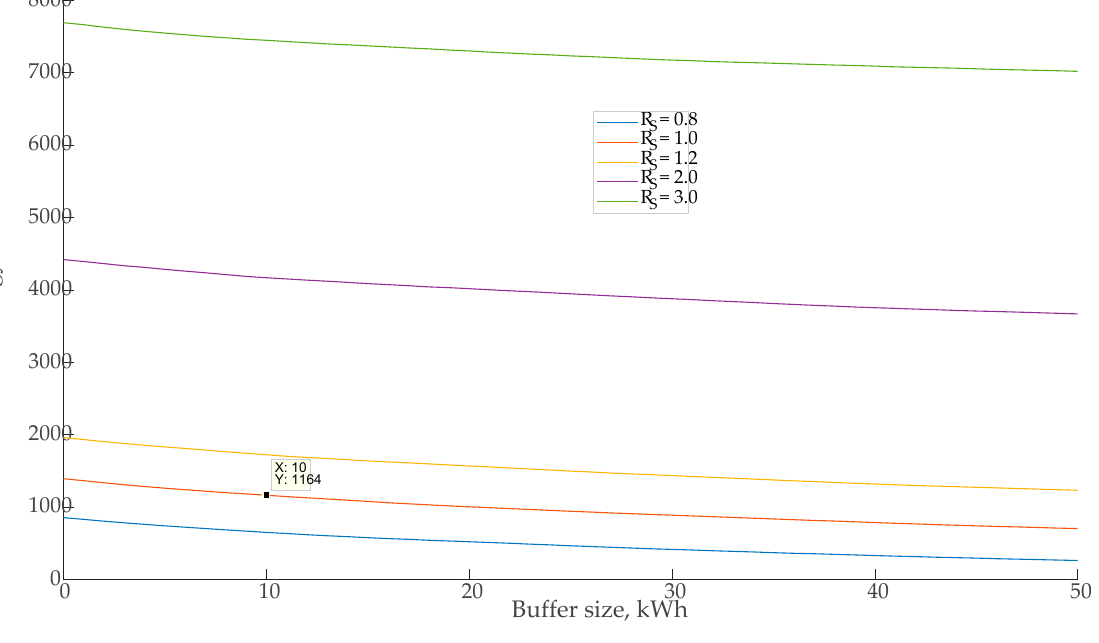
Figure 9. Influence of BB size and R S on cover factor.